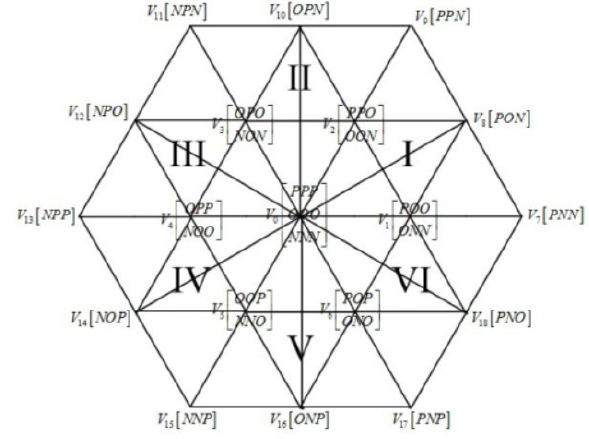
Figure 4. Vectors of switching state for three level inverter [21].